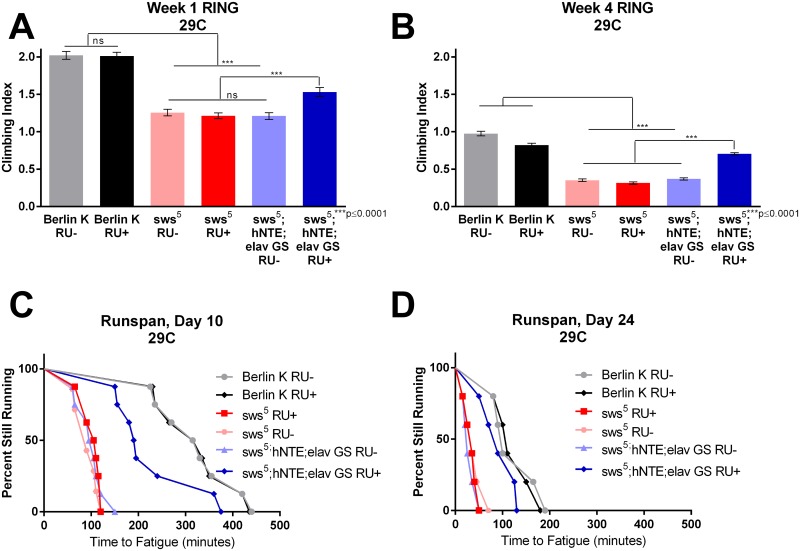
Continuous adult-specific hNTE expression improves climbing performance and endurance in sws
5 flies at 2 ages.(A) Average climbing ability is increased in hNTE rescue flies during week 1 of adult life in comparison to age-matched flies without hNTE expression (p≤0.0001), but not to the level of the wild-type Berlin K flies (p = 0.0001). Flies were assessed daily on days 4 through 8 at 29°C. Climbing performance was assessed on a minimum of 2 cohorts. Data were analyzed using two-way ANOVA with Bonferroni post-test. (n≥112, p≤0.0001, genotype effect, p<0.0001, RU effect, p = 0.0233, RU-by-genotype effect, p = .0003). (B)Average climbing performance assessed on days 25–29 (week 4) of adulthood is improved in hNTE rescue flies in comparison to age-matched flies without hNTE expression (p≤0.0001), but not fully rescued to wild-type levels (p≤0.0001). Climbing was assessed on a minimum of 2 separate biological cohorts. Data were analyzed using two-way ANOVA with Bonferroni post-test. (n≥84, p≤0.0001, genotype effect, p<0.0001, RU effect, p = .0043,RU-by-genotype effect, p<0.0001). Data from both timepoints (2A and 2B) were combined to assess effects across age, age effect, p<0.0001, RU effect, p<0.0001, interaction, p = 0.8656. Thus, there is an age-independent effect of RU on climbing. (C) Time to fatigue is increased in hNTE rescue flies compared to sws
5 flies and uninduced controls. Endurance experiments are analyzed statistically by log-rank (n≥150 p≤0.0001). Flies were aged at 29°C and assessed for time-to-fatigue on the 10th day. (D) 24-day old control flies exhibit age-related decline in endurance relative to day 10. sws
5 mutants and RU- control flies display marked reduction in time-to-fatigue- in comparison to Berlin K flies (log-rank, p≤0.0001). Time-to-fatigue is increased in hNTE rescue flies compared to sws
5 and RU- controls (log rank, p≤0.0001), but not fully restored to wild-type (log rank with Pearson correlation, p = 0.0020). Endurance was assessed a minimum of 3 times to confirm reproducibility. n≥100 for all day-24 assessments.